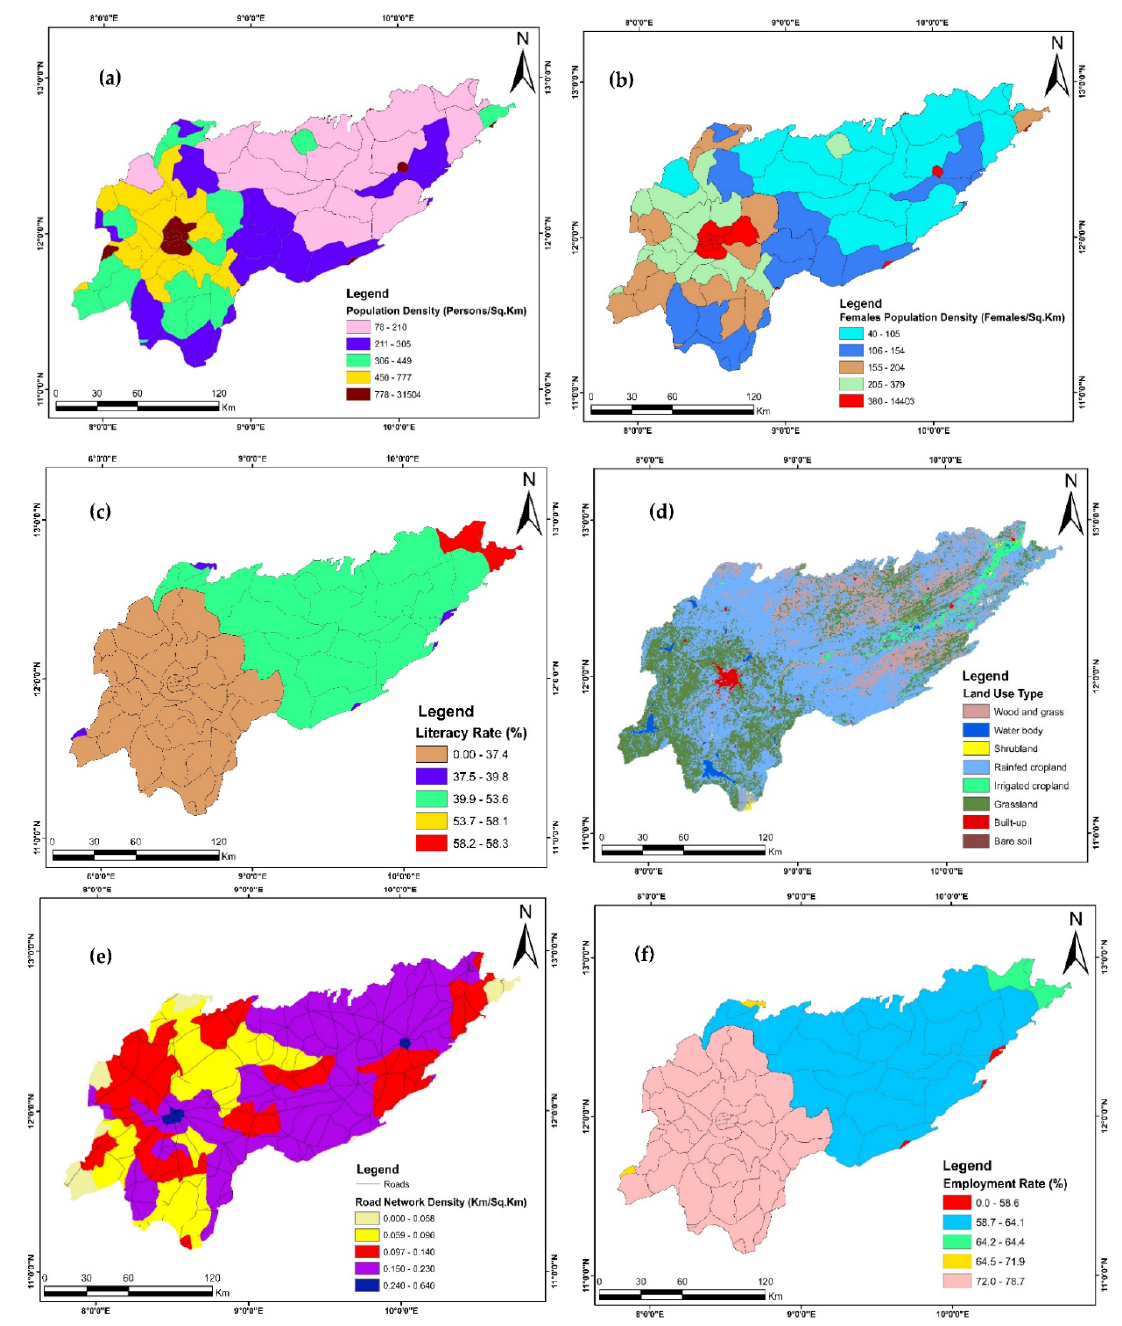
Figure 4. Flood vulnerability indicators. ( a ) Population density. ( b ) Female population density. ( c ) Literacy rate. ( d ) Land use type. ( e ) Road network density. ( f ) Employment rate. Kano central and Hadjia LGA of Jigawa state. The high road network density class (0.150– 0.230) covers about 50% of the study area in the north ‐ eastern part of the basin. Other portions of the study area are in the moderate class (0.097–0.140), low class (0.059–0.096), and very low class (0.00–0.058) of road network densities.